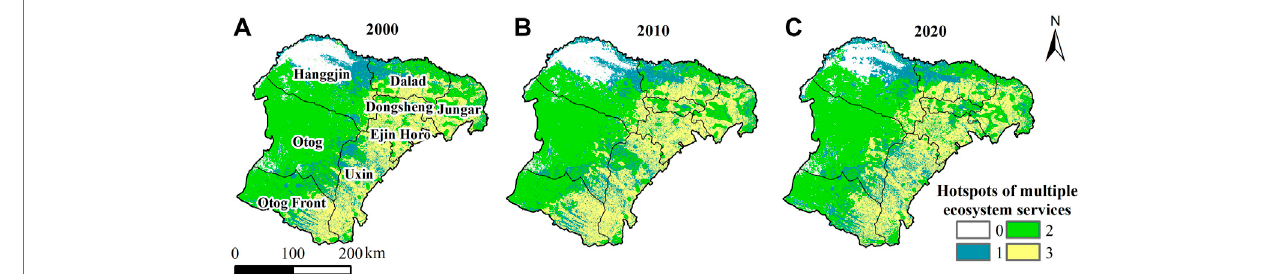
Frontiers in Earth Science |